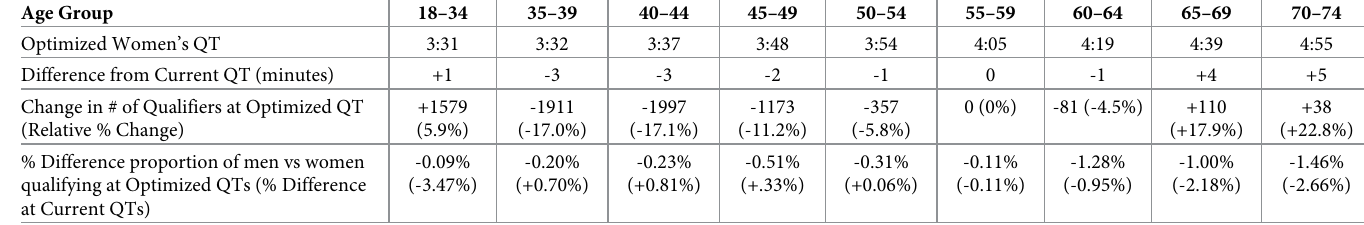
Table 2. Optimized women’s qualifying times found from Eq 2. The difference in minutes between the Current QTs and the Optimized QTs are given in the second row. The absolute difference in the number of qualifiers at the Current QTs compared to the Optimized QTs is shown in the third row with the relative percent change dis- played in parentheses. The last row gives the percent difference of the proportion of men and the proportion of women that qualify at their respective qualifying times. A negative value indicates a higher proportion of men qualify relative to women. Age Group